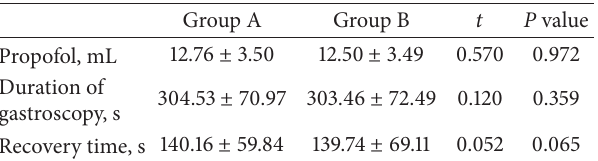
Figure 2: MAP, heart rate, and SpO 2 of Group A and Group B before, during, and after gastroscopy. ∗ Significant difference between the 2 groups. Table 3: Anesthetic dose, duration of gastroscopy, and recovery time of the treatment